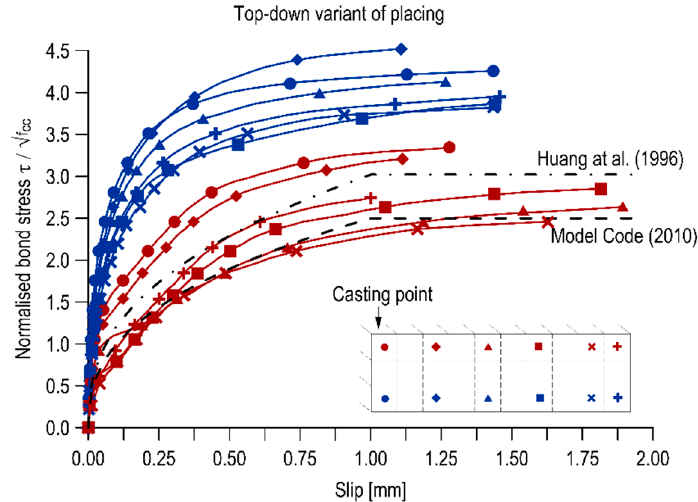
Figure 3. Bond-slip curves in the top-down cast specimen.